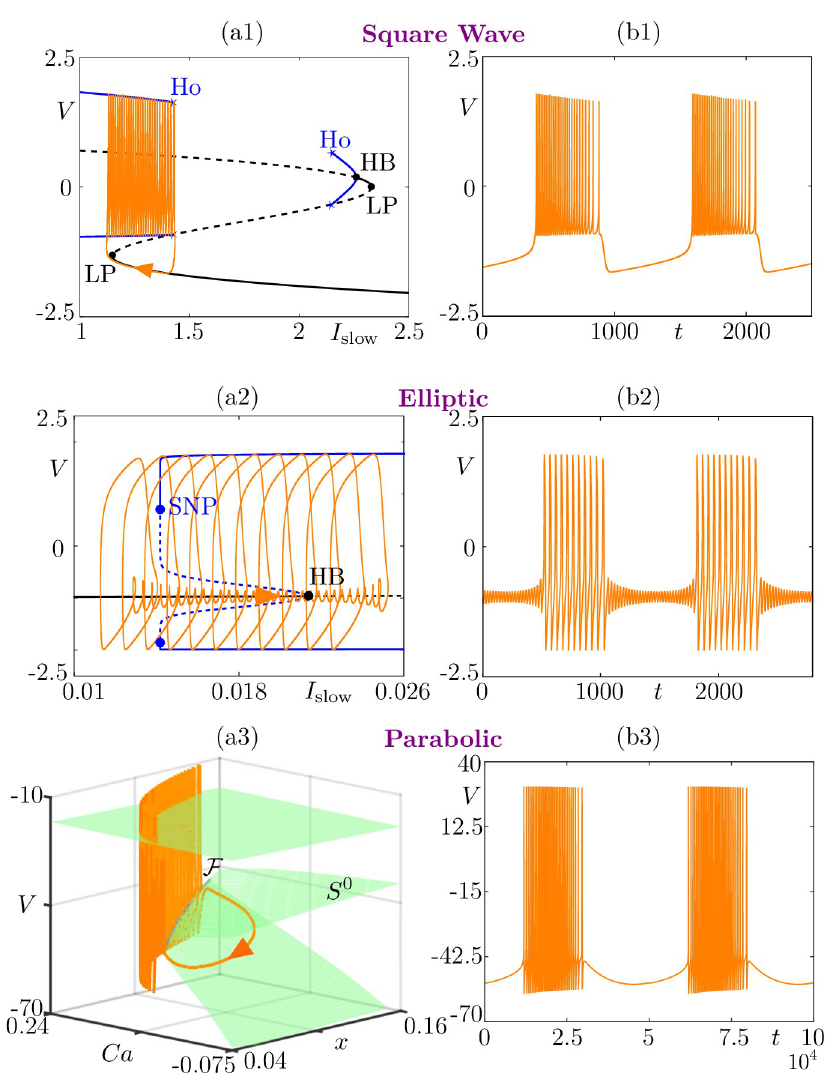
Fig 4. Rinzel classification of bursting patterns. Square-wave bursting, here in the Hindmarsh–Rose model [40] (panels (a1)-(b1)); elliptic bursting, here in the FitzHugh–Rinzel model [6,41](panels (a2)-(b2)); parabolic bursting, here in Plant’s model [42] (panels (a3)-(b3)). In each case, we show a phase-space projection of the bursting solution of the full system (orange) together with the bifurcation diagram of the fast subsystem (left panel) and the time course of membrane potential V (orange, right panel). Labels for bifurcations are as follows: Ho for homoclinic, HB for Hopf bifurcation, LP for saddle-node (limit point) bifurcation of equilibria, and SNP for saddle-node of periodic orbits. (a3) The critical manifold S 0 (green) is the S -shaped (not fully rendered) surface of equilibria of the fast subsystem; this surface is folded along the fold curve F . Equations and parameter values are given in S1 Text.